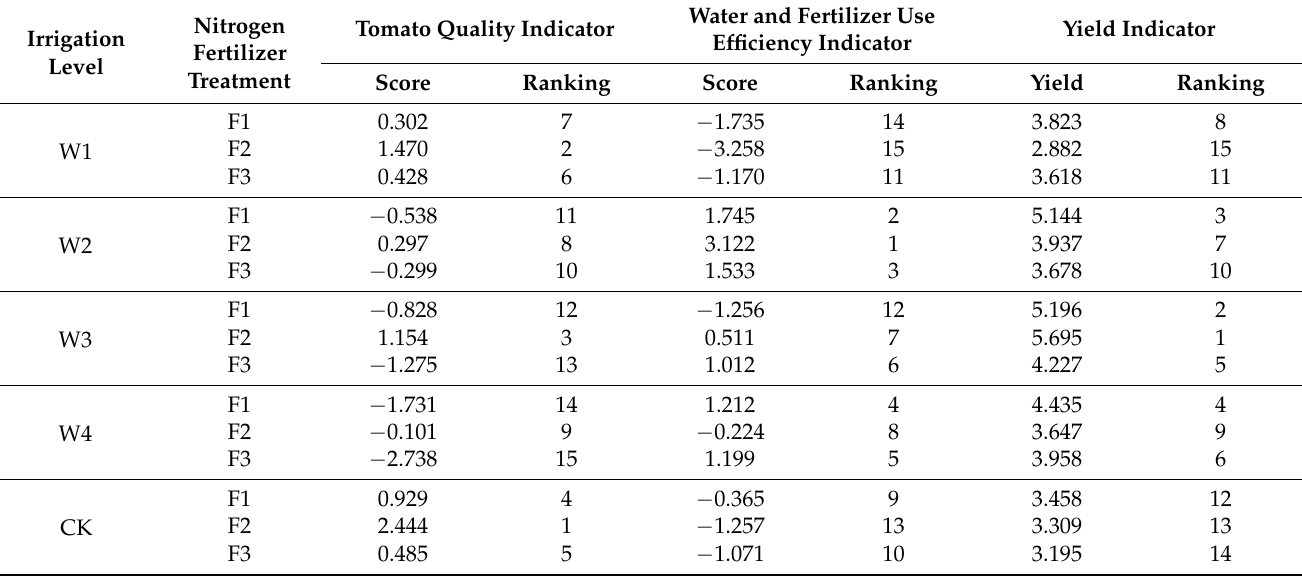
Table 8. lists the rankings and scores reflecting the three dimensions of tomatoes. Table 8. Rankings and scores reflecting the three dimensions of